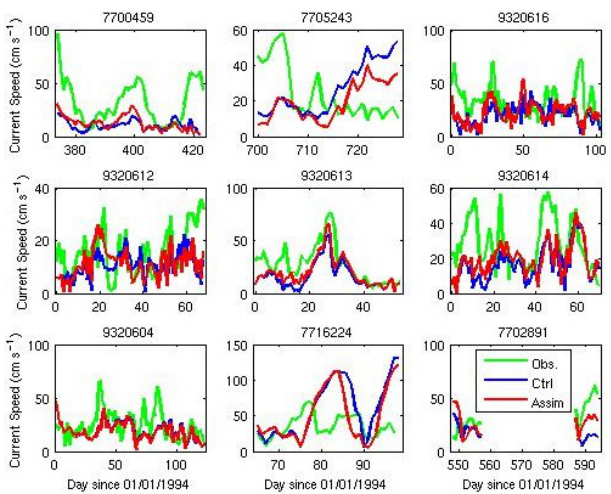
Fig. 12 Fig. 12. Daily surface current speeds simulated by HYCOM and observed by surface drifters. The green lines represent the current speed observed by the drifters, the blue lines from model without assimilation (Ctrl), and the red with assimilation